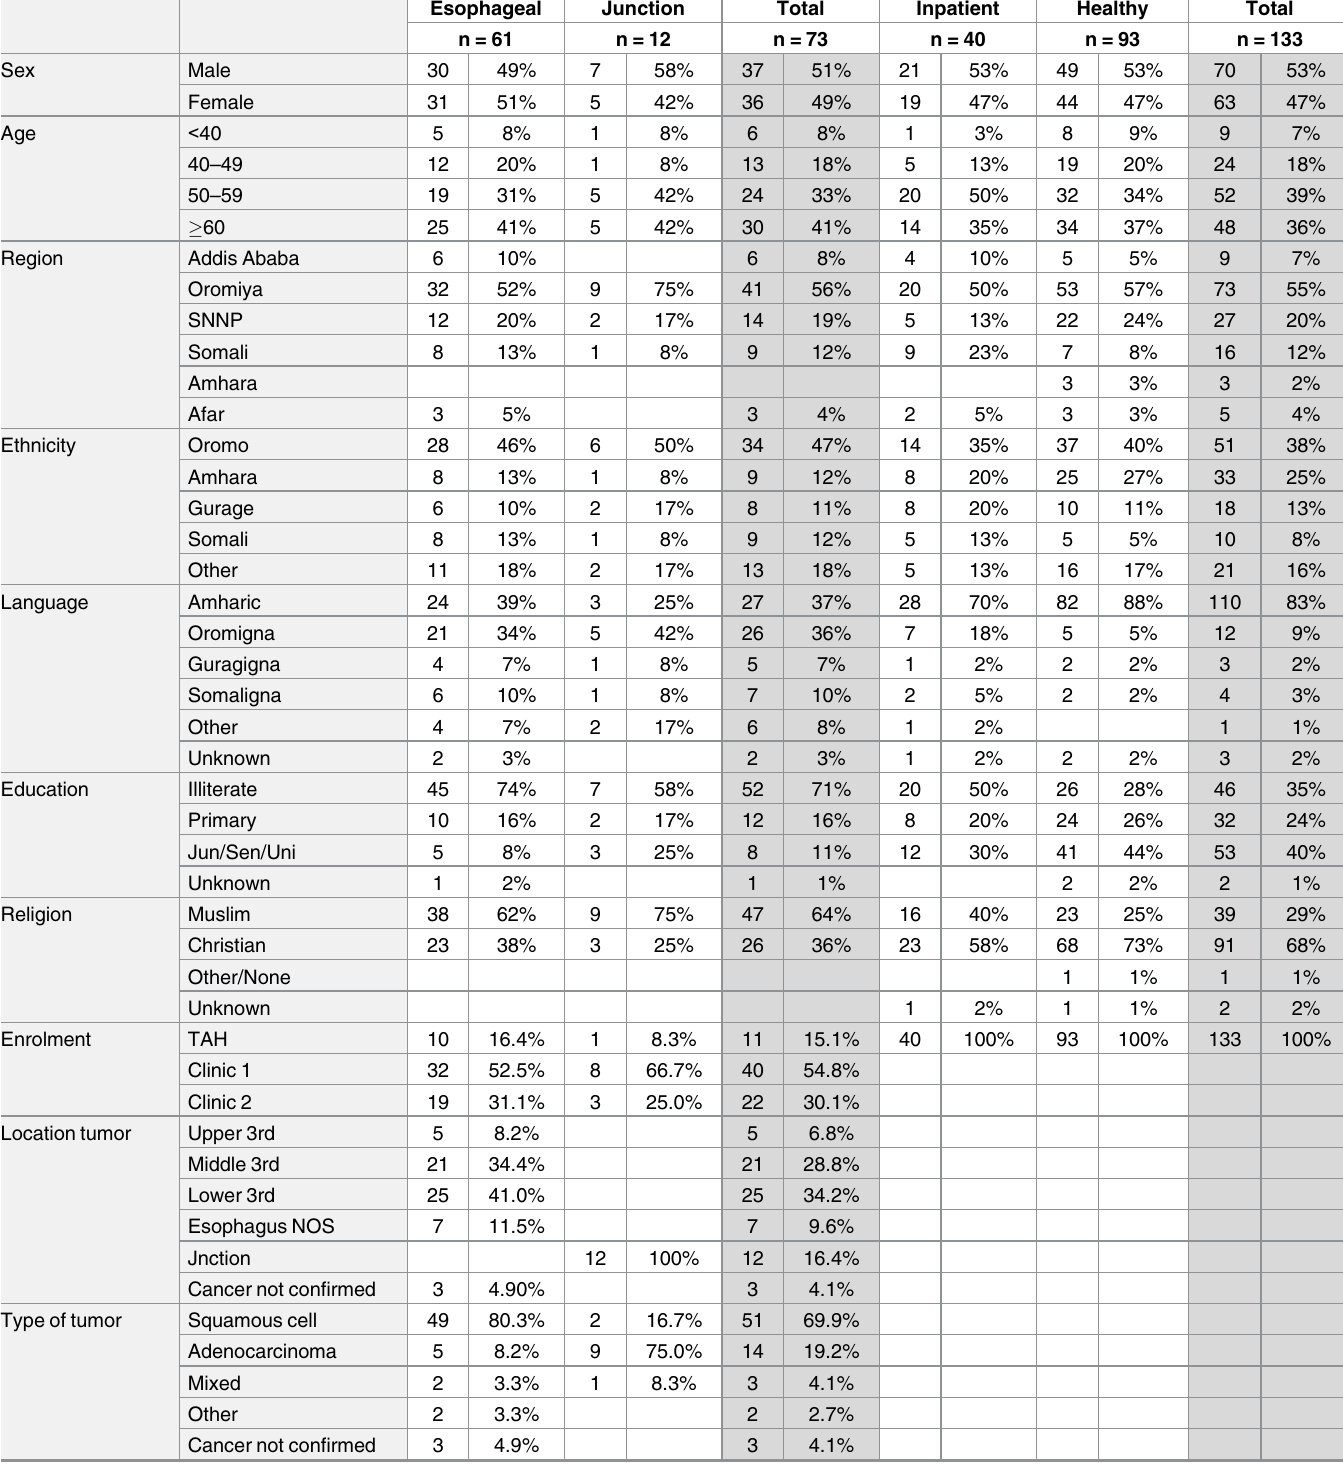
Table 1. Demographic and clinical description of study participants included in the